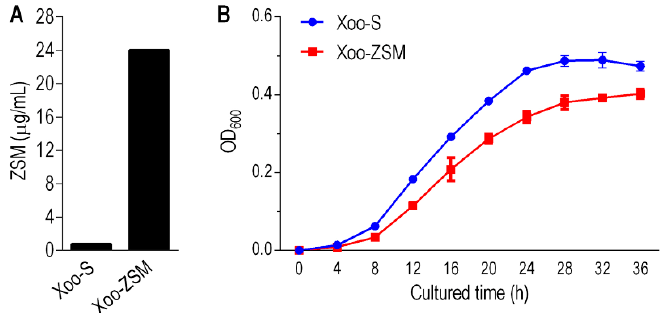
Figure 1 . The features of strain Xoo-S and Xoo-ZSM. ( A ) The minimum inhibitory concentration (MIC) of Xoo-S and Xoo-ZSM with zhongshengmycin stress. ( B ) Growth curve of Xoo-S and Xoo-ZSM. Bars: SD calculated from three biological replicates.